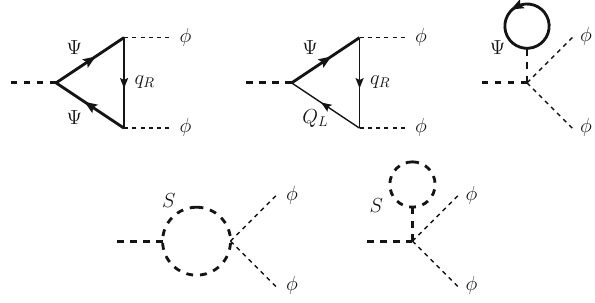
Fig. 3 One-loop diagrams contributing to the coefficient C ( 1 ) φφ in